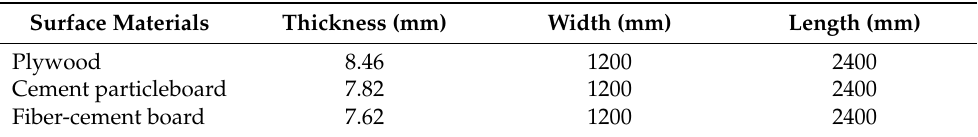
Table 1. Dimensions of the plywood, cement particleboard, and fiber-cement board used in this research.